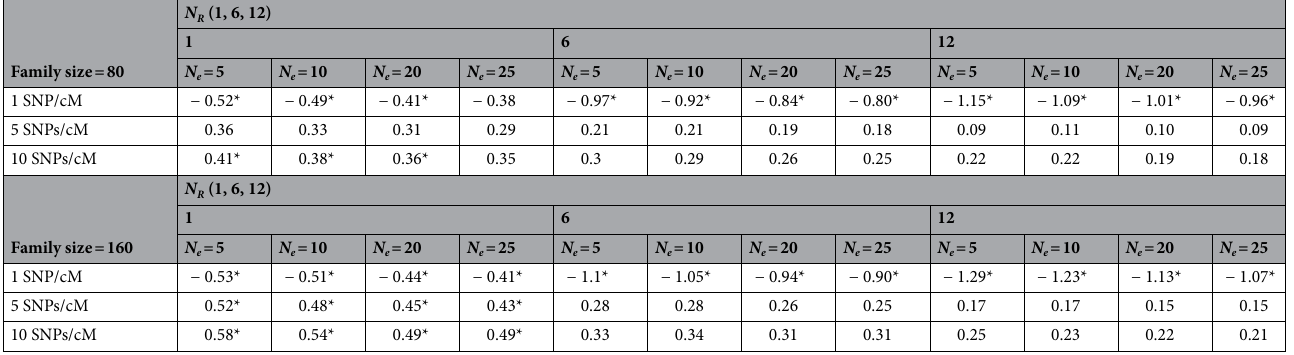
Table 2. Differences in standardized genetic gains between GBLUP and BLUP for combinations of N R , N e (5, 10, 20, 25), marker density (1, 5, 10 SNPs/cM), and family size 80 (top table) and 160 (bottom table). An asterisk indicates significant differences (alpha = 0.05). N R = 1 means no-cloning (1 ramet per